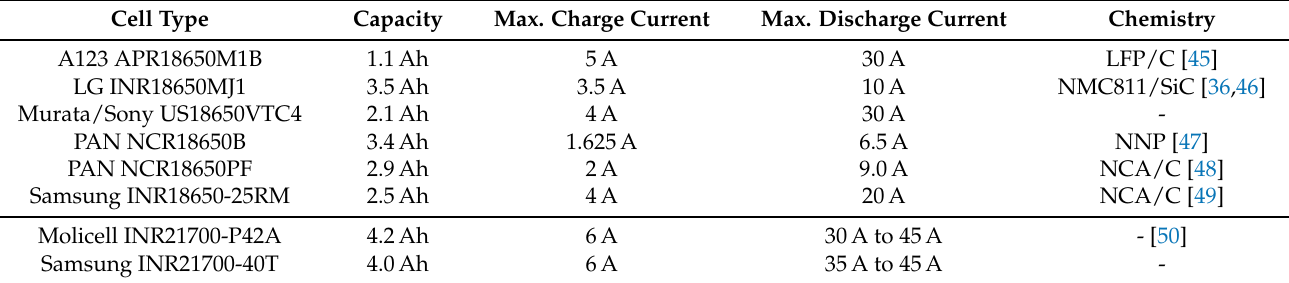
Table 1. Cell types used for jelly-roll gap